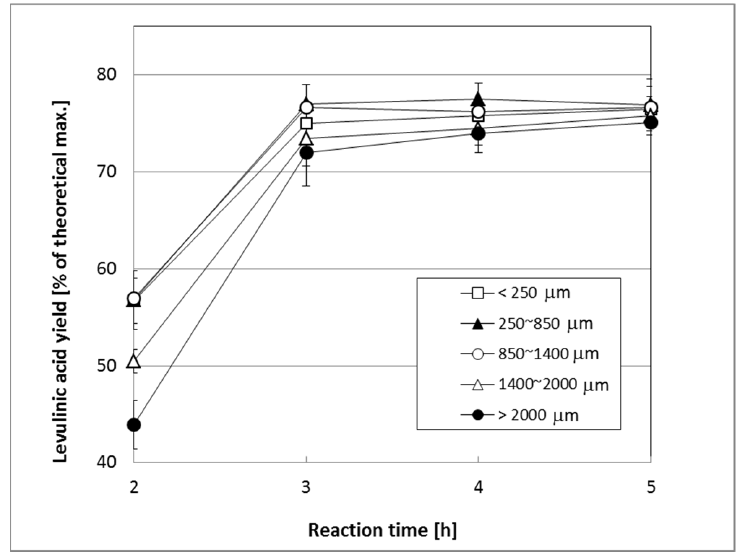
Figure 2. Effect of particle size on LA production using CS upon reaction time. Note . Particle size 250–2000 µm; reaction conditions: 1 M HCl, 150 °C, 50 g/L solid loading.